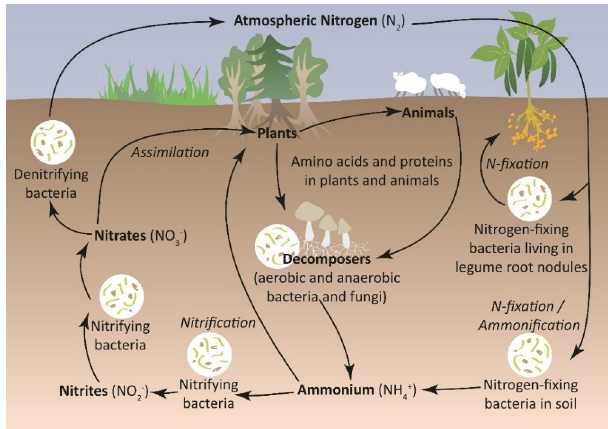
Figure 7. Schematic figure for terrestrial nitrogen